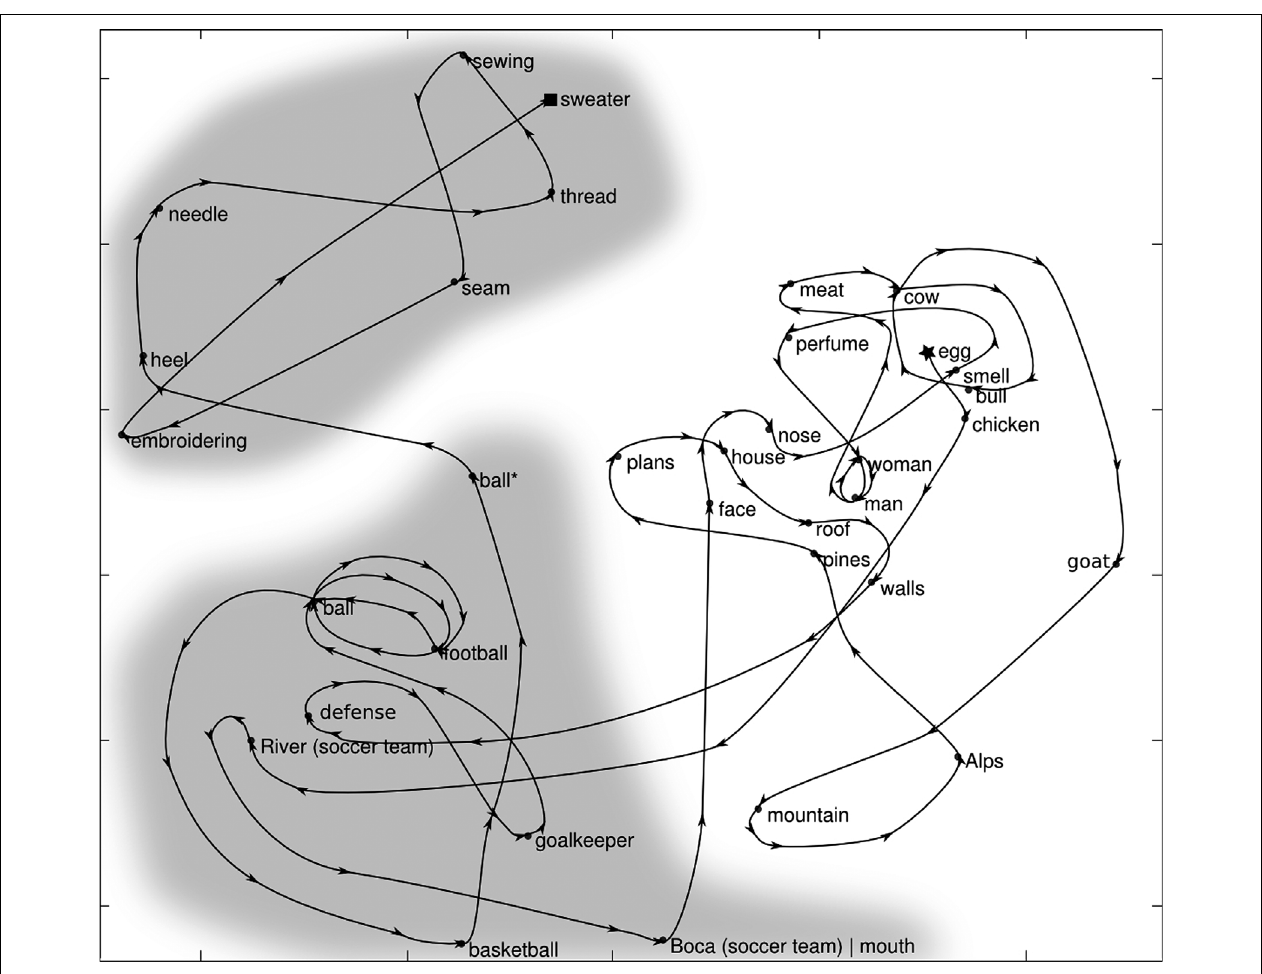
FIGURE 1 | The plane corresponds to the Sammon projection of a subgraph of the word co-occurrence graph. This classifi cation revealed two distinct clusters which can be mapped to semantic categories. Within this space,